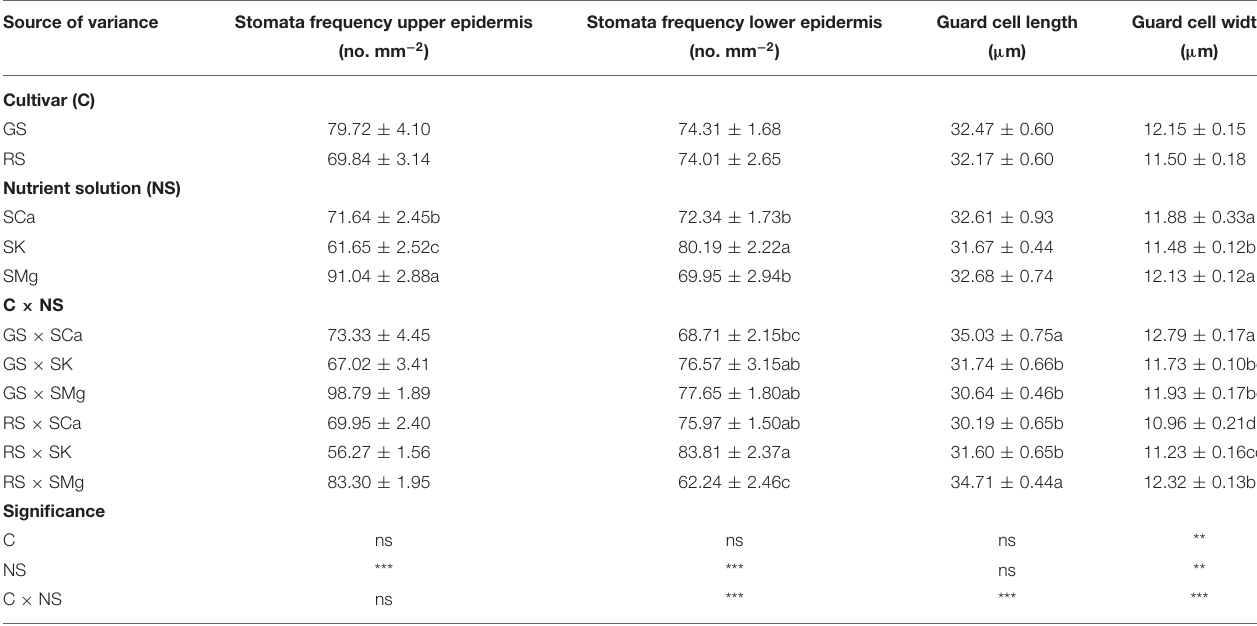
TABLE 3 | Effects of the C and of the NS on leaf stomatal parameters. Source of